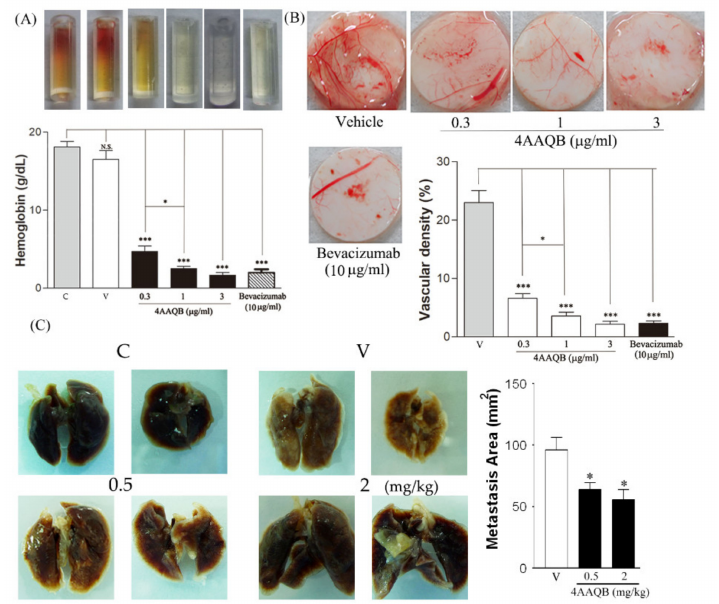
Figure 6. The effect of 4AAQB on the in vivo angiogenesis model. ( A ) DIVAA tubes were pho- tographed and the hemoglobin level was measured. Data are represented as means ± SEM ( n = 6); ( B ) the blood vascular densities of CAMs were calculated and is represented as mean ± SEM ( n = 5); ( C ) the PC3 cells’ metastasis area of the lung surface is shown in white, and the background, in dark red. The white area was quantified using the ImageJ software. Data are represented as means ± SEM ( n = 8). * p < 0.05 and *** p < 0.001 compared to the control (C) or vehicle (V)